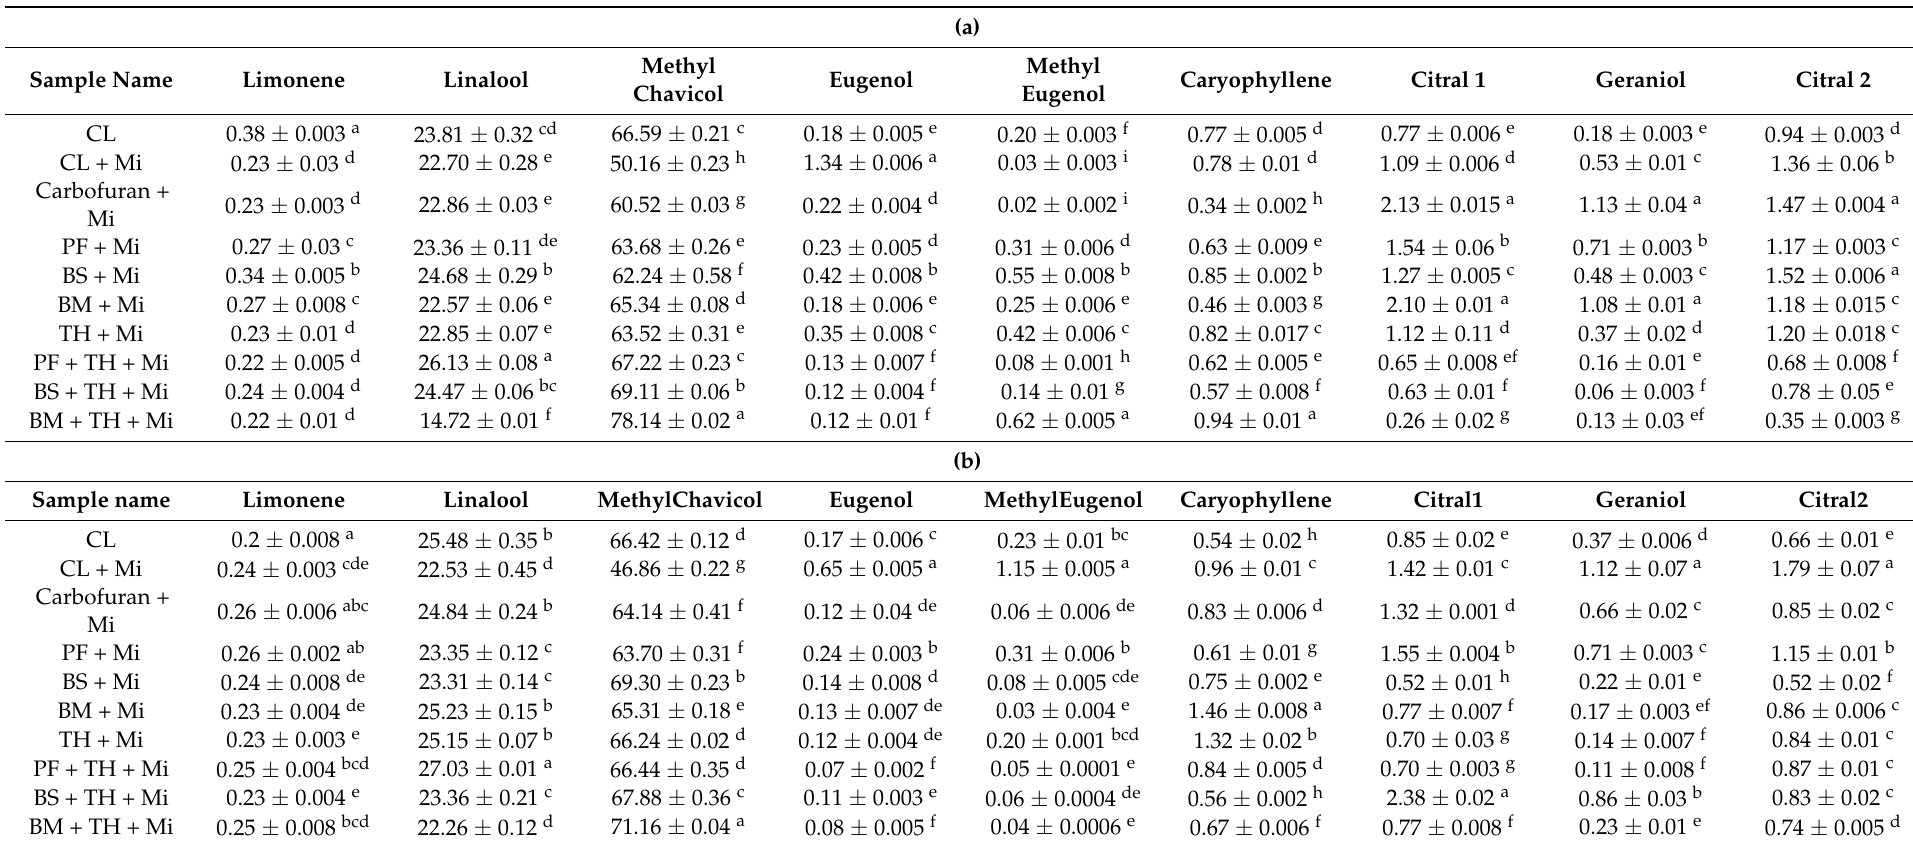
Table 4. ( a ) Essential oil chemical constituent profiling (relative percent from total constituent) of Ocimum basilicum grown under sterile soil conditions and treated with different bioinoculants in single or in consortium. ( b ) Essential oil chemical constituent profiling (relative chemical constituent percent from total constitutes) of Ocimum basilicum grown under natural soil conditions and treated with different bioinoculants in single or in